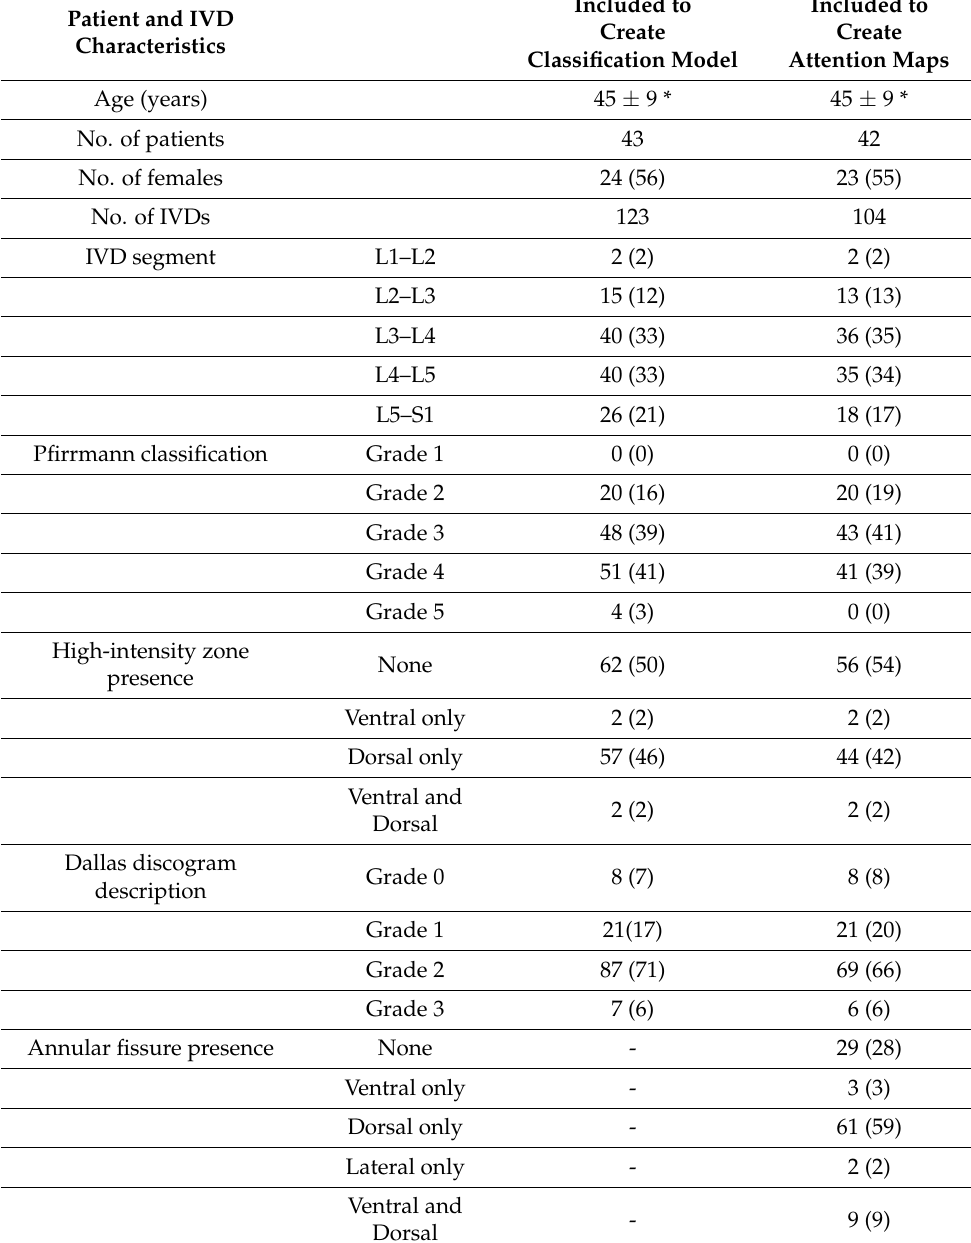
Table 3. Demographic and radiographic characteristics of included